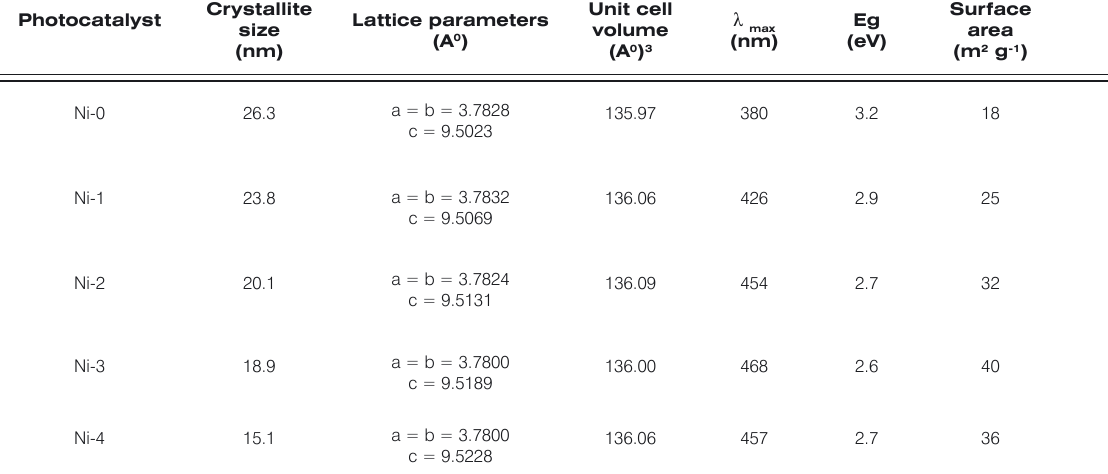
Table 1. Detailed characterization of Ni 2+ doped